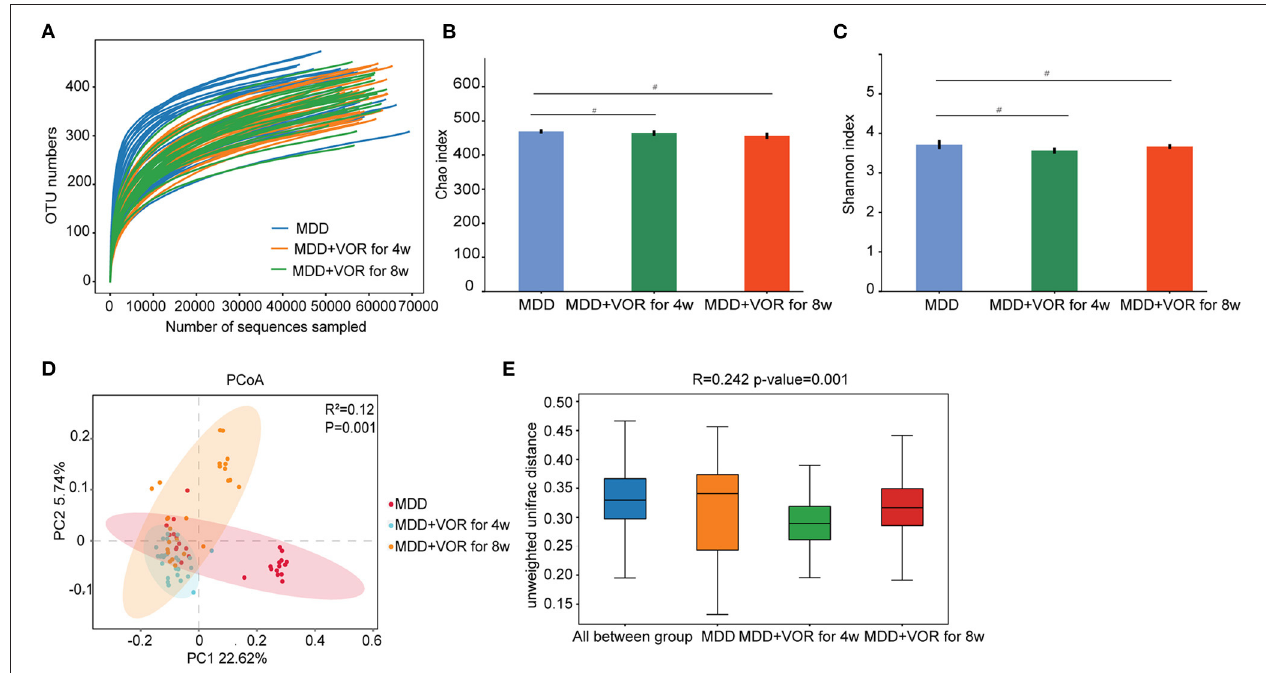
FIGURE 4 | Alpha and beta diversity measures in MDD patients before and after vortioxetine hydrobromide treatment. (A) Rarefaction curve between groups. (B) α -Diversity on the Chao index between groups. (C) α -Diversity on the Shannon index between groups. (D) PCoA of the gut microbiota metagenomes between groups. (E) β -Diversity on unweighted UniFrac between groups. # p < 0.05.